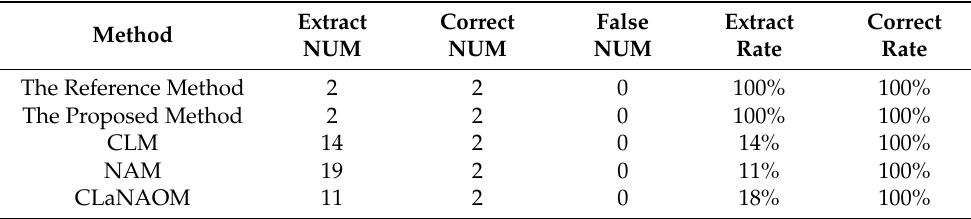
Table 19. The mountain vertices extraction results for each method using the sixth dataset.